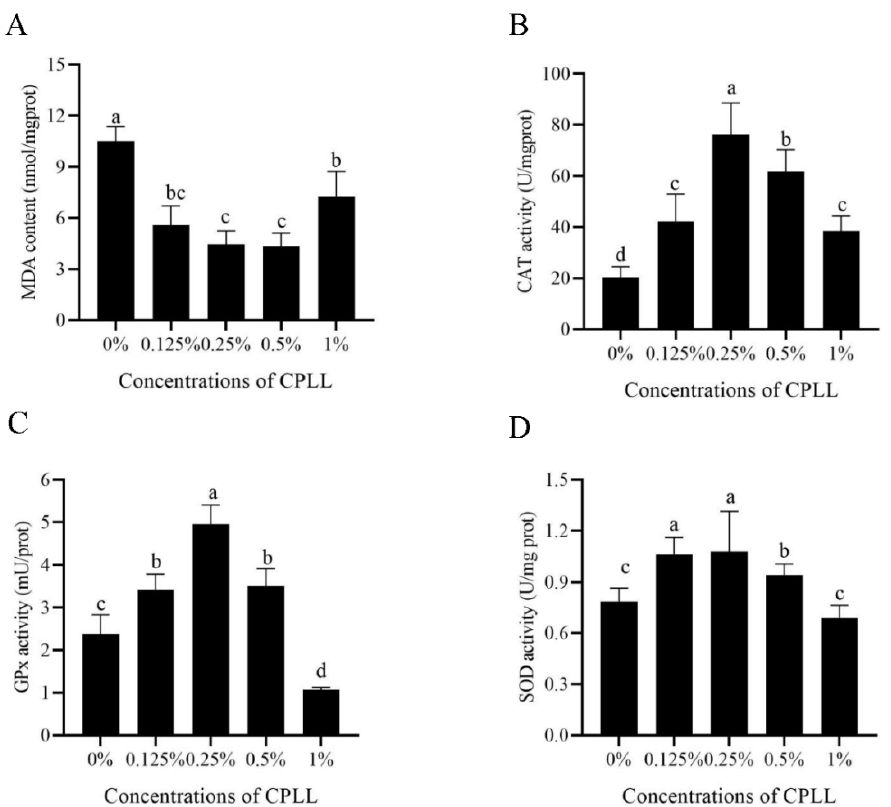
Figure 3. Effects of supplementation with different concentrations of CPLL to the freezing medium on post-thaw boar sperm MDA level ( A ), CAT activity ( B ), GPx activity ( C ), and SOD activity ( D ). Values are specified as mean ± standard error of the mean (SEM). Columns with different lowercase letters differ significantly ( p < 0.05). CAT, catalase; GPx, glutathione peroxidase; SOD, superoxide dismutase, n = 5.